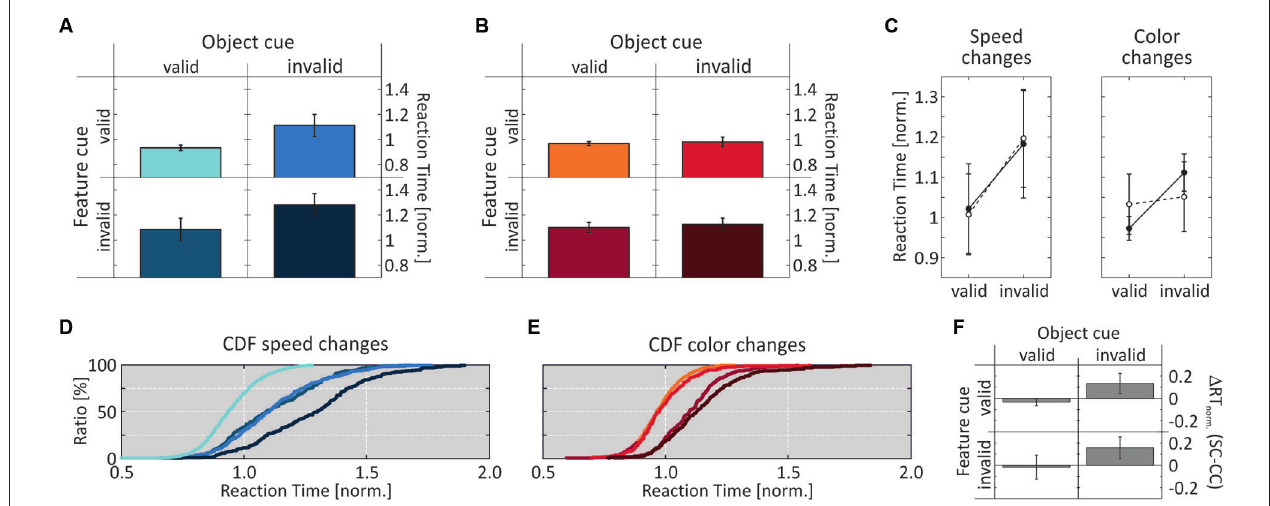
feature cue, plotted values represent the row mean of the data shown in A, B and for the object cue they represent the column mean. (D, E) Cumulative distributions of normalized RTs. Line colors correspond to cue conditions as in (A, B) . (F) Speed- and color-change difference of mean normalized RTs for corresponding cue conditions. Error bars indicate SD throughout the figure.